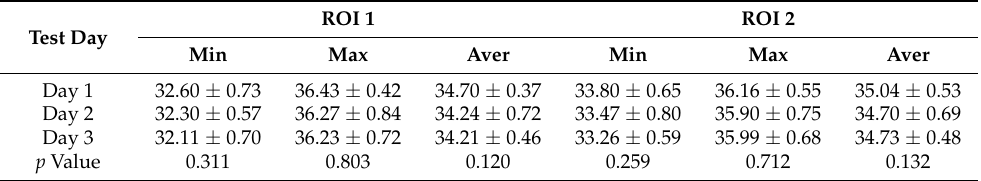
Table 1. Temperature variations during three consecutive days of monitoring with IRT ( n =